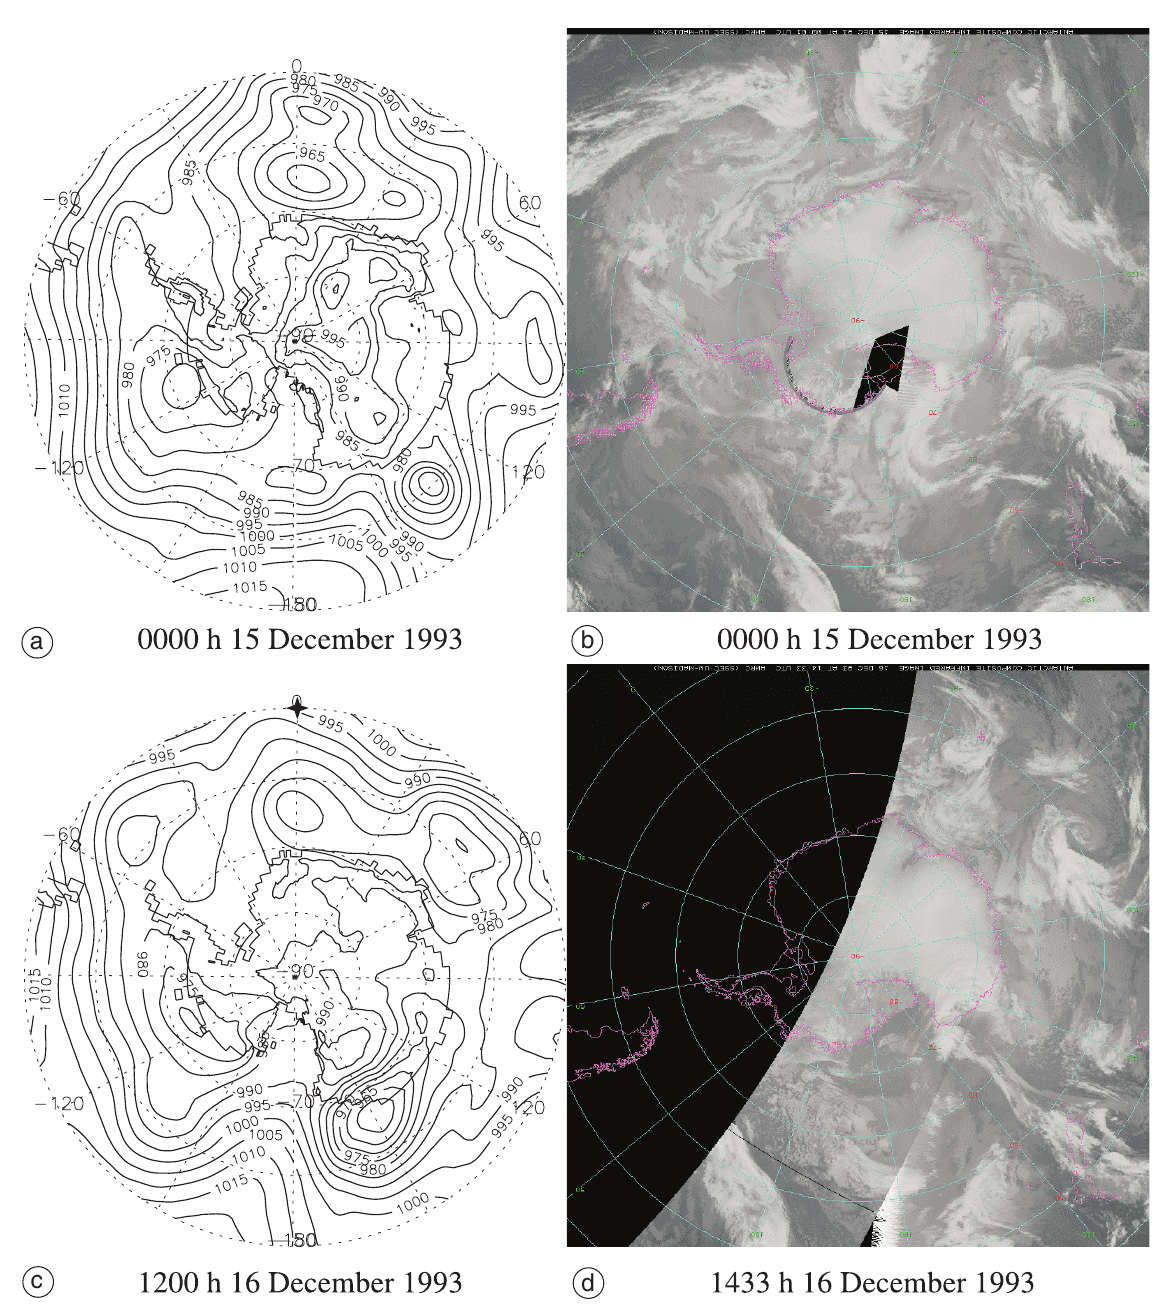
Fig. 11a-d. ECMWF analyses of mean sea level pressure charts and composite infrared satellite images for 0000 h 15 December (a,b) and 1200 h 16 December 1993 (c,d),